Question: Write a descriptive caption for this figure.
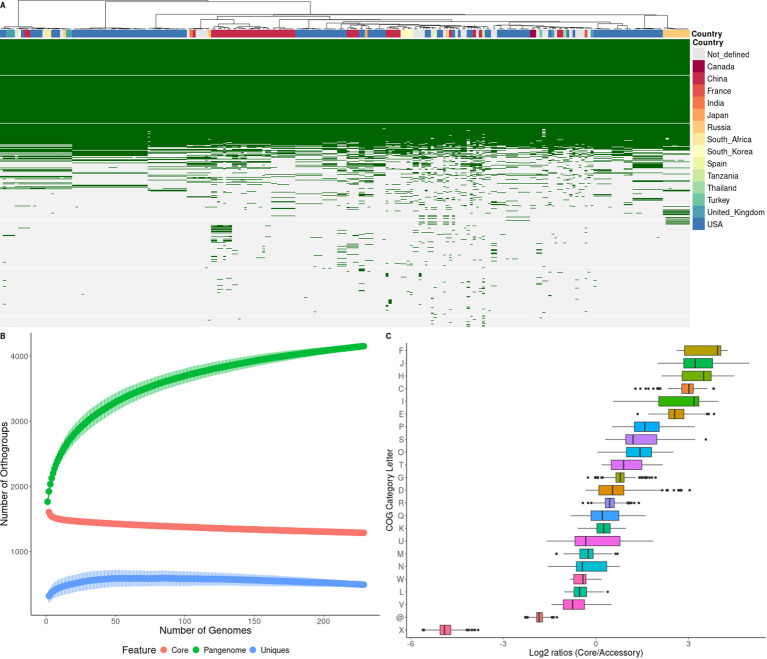
Answer: Pangenome analysis of B. bifidum utilizing 229 high-quality genomes (including the 900791 strain). (A) Ortholog conservation heatmap for the genomes according to their geographical origin, clusterized their shared gene family profile. (B) Pangenome accumulation curve suggests that the pangenome for B. bifidum is open (gamma value = 0.16, according to Power Law equation). (C) Analysis for the Log2 ratios of the percentage of core/near-core (>= 95% prevalence) versus accessory (< 95% prevalence) genes for each COG category among pangenomes “(@” = no COG category). COG category descriptions are available on the COG Database website ( https://www.ncbi.nlm.nih.gov/research/cog ).